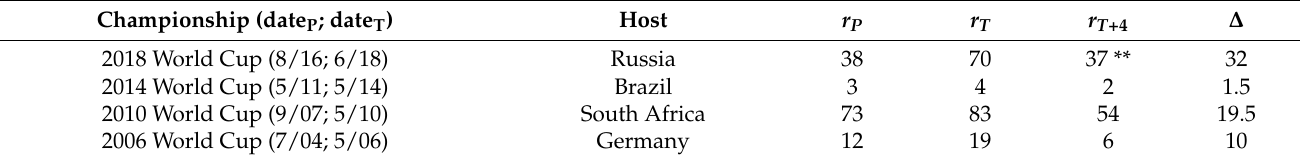
Table A1. The hosts of the World Cup, the Euros (UEFA), and the Asian Cup (AFC) from 1994 and their positions in the FIFA